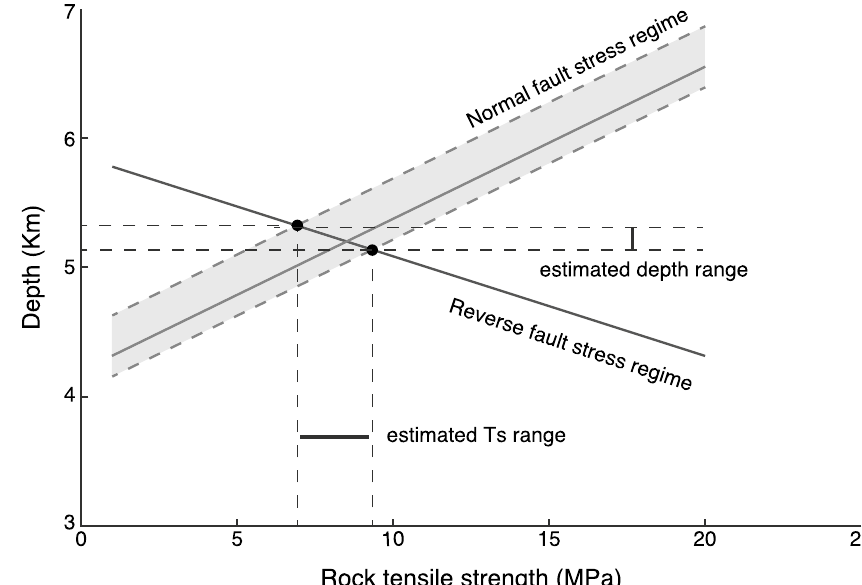
Figure 4. Relationship between the rock tensile strength and depth for normal and reverse fault stress regimes. See the text for the conversion from vertical stress to